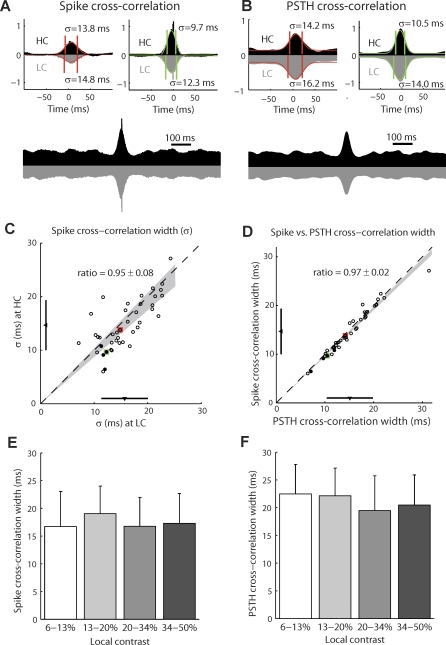
Spike Timing Precision across Cells Is Coarser than within Cells and Is Largely Insensitive to Contrast(A) Spike cross-correlation for pairs of simultaneously recorded cells that exhibited correlated activity. Same conventions as in Figure 2B. Top left: Typical pair of X ON cells. Top right: Pair consisting of a Y OFF cell and an X OFF cell that received common retinal input. Bottom: Average spike cross-correlation over all 41 pairs.(B) PSTH cross-correlation for pairs of simultaneously recorded cells that exhibited correlated activity. Same conventions as in Figure 2A. Top: Same example pairs as in (A). Bottom: Average PSTH cross-correlation over all 41 pairs.(C) Temporal width of the spike cross-correlation for all included cell pairs (n = 41). Same conventions as in Figure 2D.(D) Comparison of the PSTH and spike cross-correlations at HC.In (C and D), black dots correspond to pairs sharing common retinal input and colored dots correspond to the two example pairs from (A and B).(E) Temporal width of spike cross-correlation for all included cell pairs, computed on the firing events for which both cells in the pair experienced the same level of local contrast. Each bar represents the mean + 1 standard deviation (n = 41 cell pairs) at the corresponding range of local contrast.(F) Temporal width of PSTH cross-correlation for all included cell pairs (n = 41), computed on the firing events for which both cells in the pair experienced the same level of local contrast. Each bar represents the mean + 1 standard deviation.